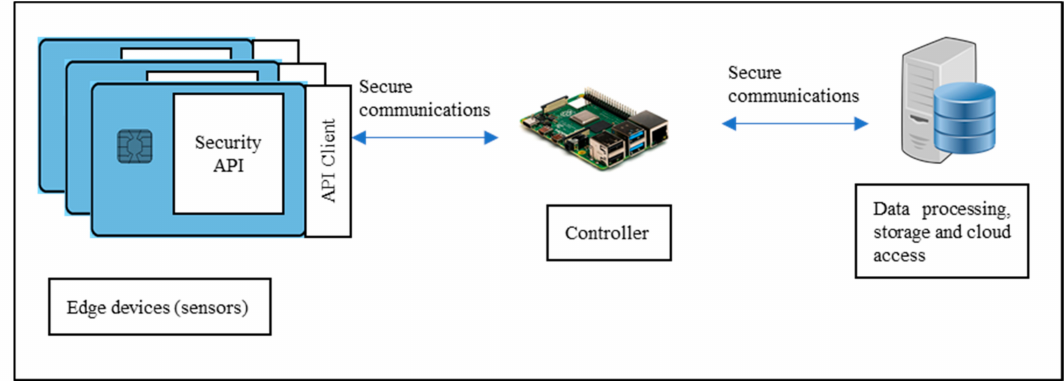
Figure 3. Configuration 2: “Thin secure element” as edge device / sensor. The Controller has enough processing resources to utilise standard security libraries to provide secure communications to the data processing server. The API Client is an external implementation (a micro-controller using a serial port) on the same board as the thin secure element.